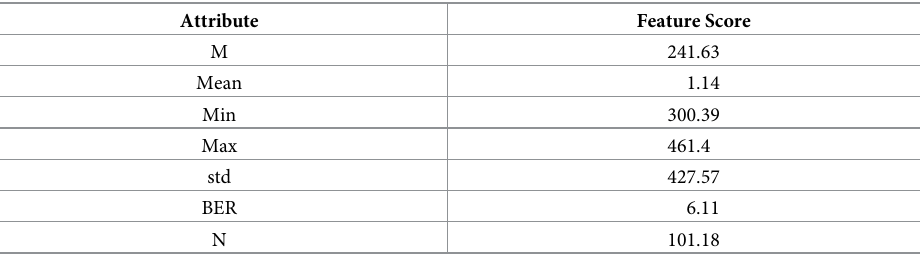
Table 2. Feature score of attributes.